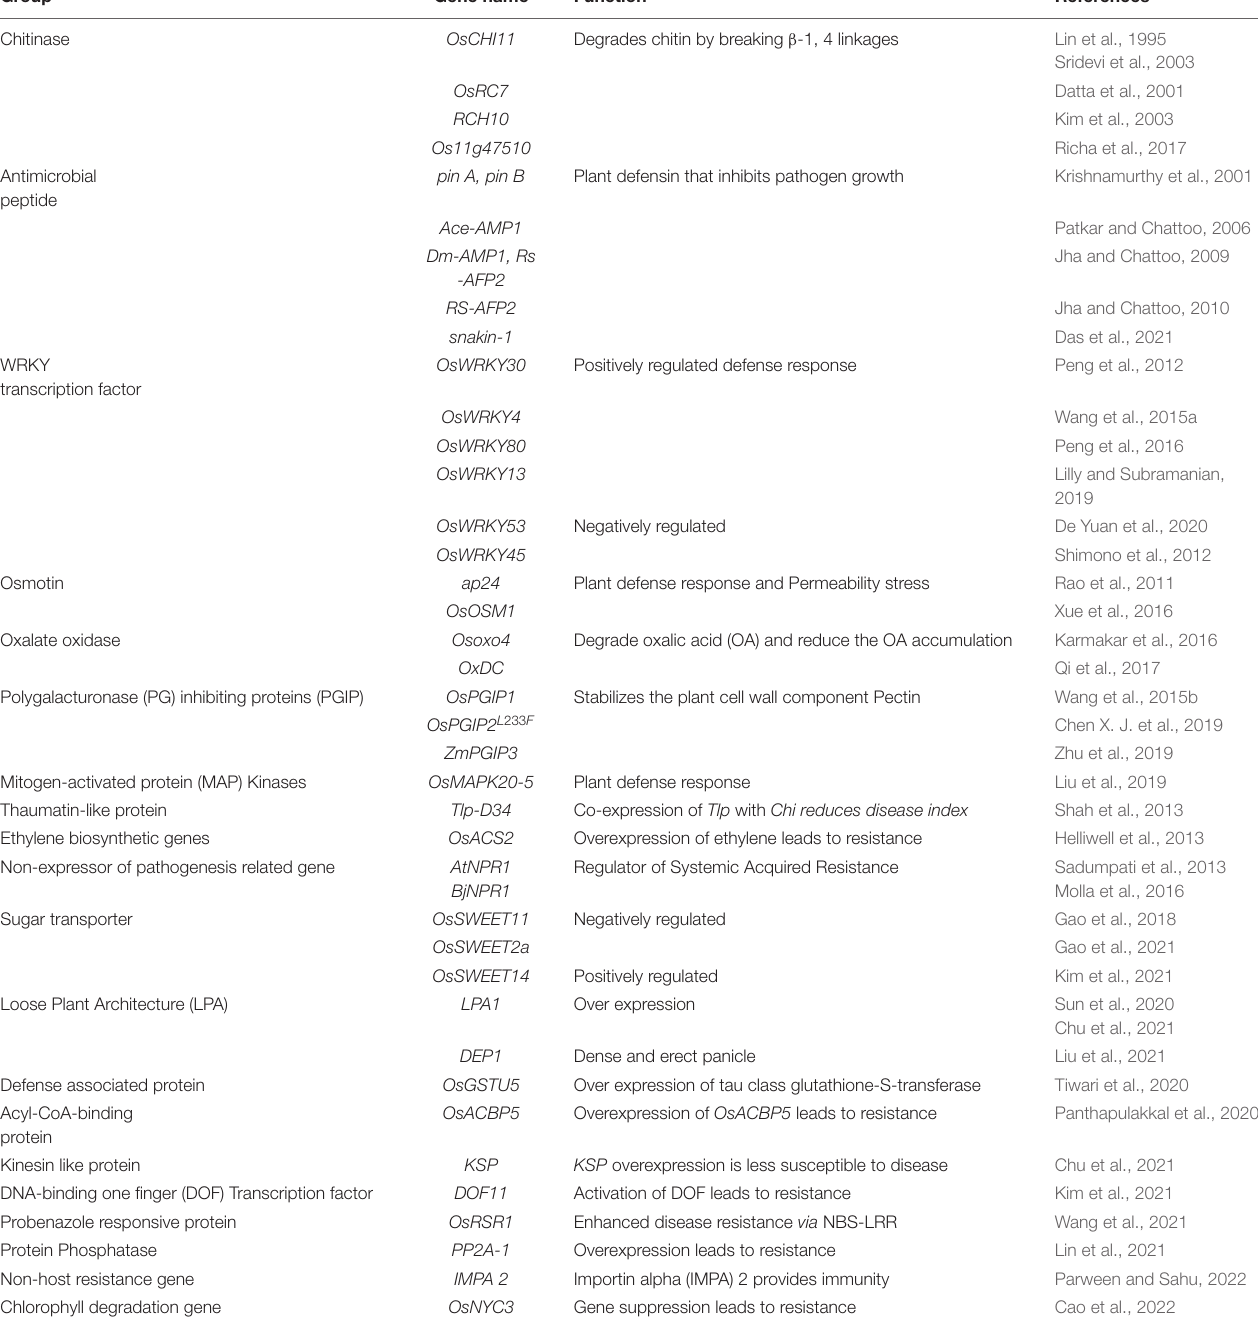
TABLE 5 | Genes reported for sheath blight resistance in